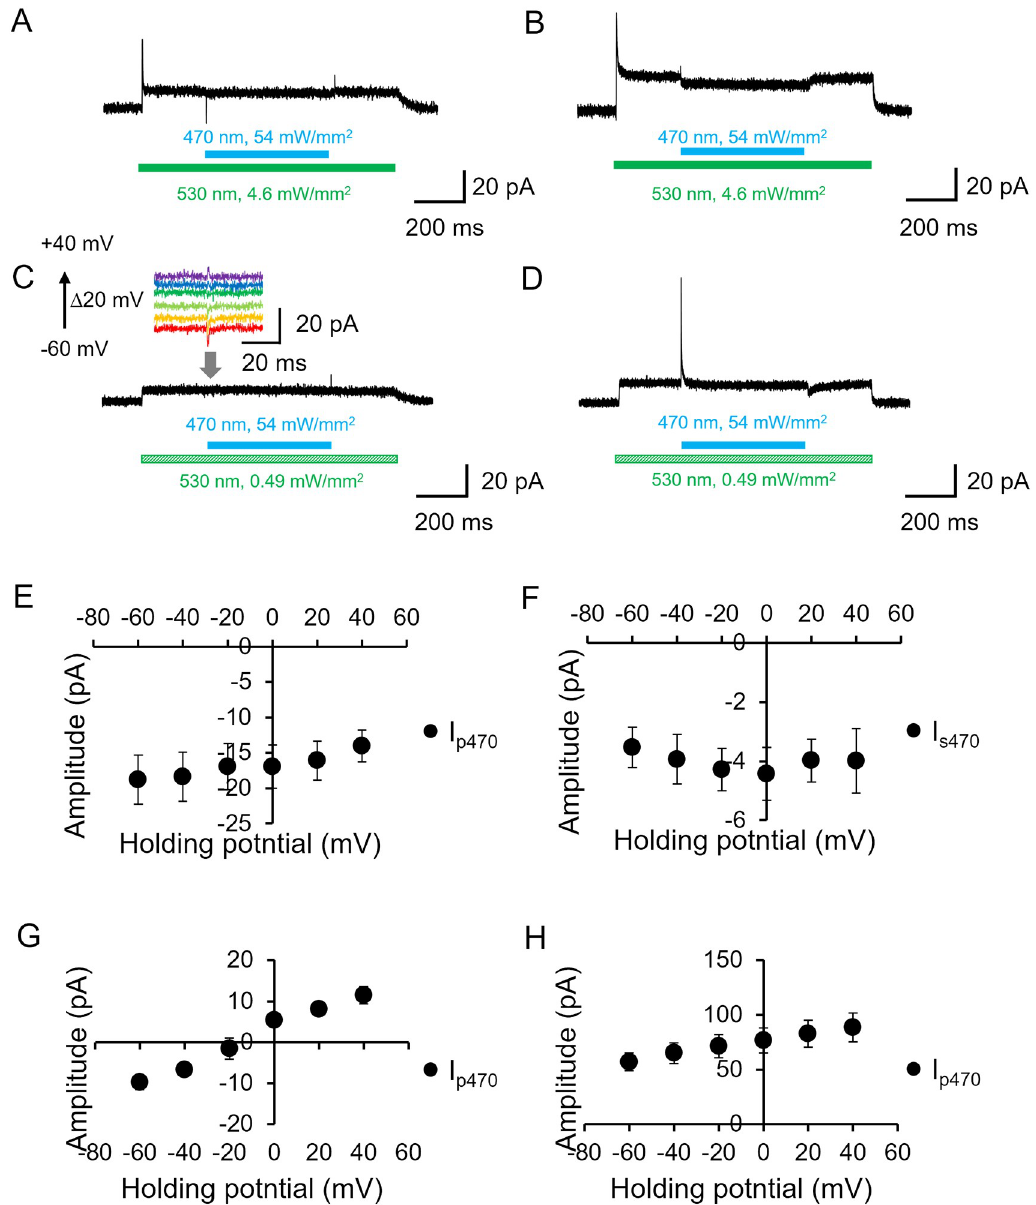
Fig 4. Effect of additional blue light (probing M intermediate). A and B, Representative photocurrent traces in the absence (A) and presence (B) of intracellular NaCl (110 mM) at pH 7.4 while the bath solution contained 140 mM NaCl a pH 7.4. The membrane voltage was clamped at 0 mV. Blue LED (470 nm at 54 mW/mm 2 ) was illuminated on top of a green LED illumination (530 nm at 4.6 mW/mm 2 ), as shown by colored bars under the current traces. C and D, The recordings as A and B with a green light (530 nm at 0.49 mW/mm 2 ) in the absence (C) and presence (D) of intracellular NaCl. The inset in C shows enlarged traces upon blue light illumination at different membrane voltages. E-H, Current-voltage relation (I/V plot) of the photocurrent during additional blue light illumination (n = 6). The peak component Ip 470 and the steady state level (Is 470 ) were plotted. E and G, in the absence of intracellular NaCl. F and H, in the presence of 110 mM NaCl. E and F, Strong green light (6.6 mW/mm 2 ). G and H, Weak green light (0.49 mW/mm 2